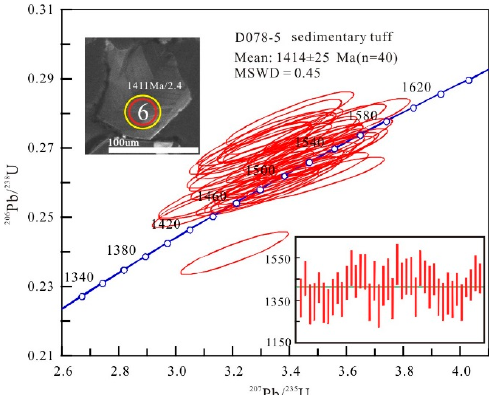
Figure 9. CL images and concordia plots of zircon U–Pb dating for the sedimentary tuff of Dongchuan (D078-5).